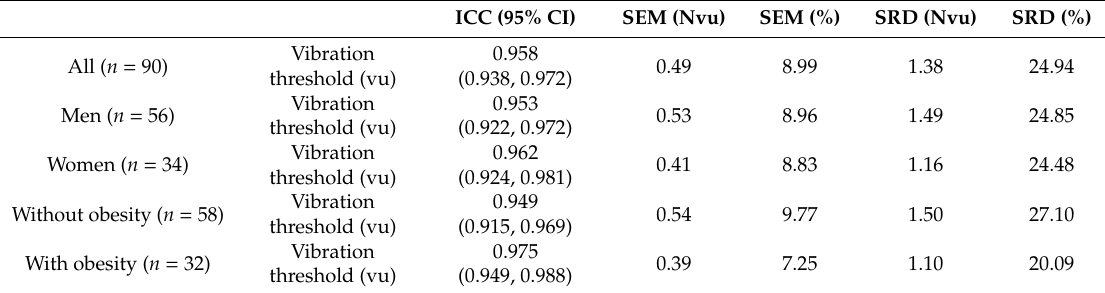
Table 3. Test-retest reliability of the vibration perception threshold test in 2 measurements with an interval of days between measurements.